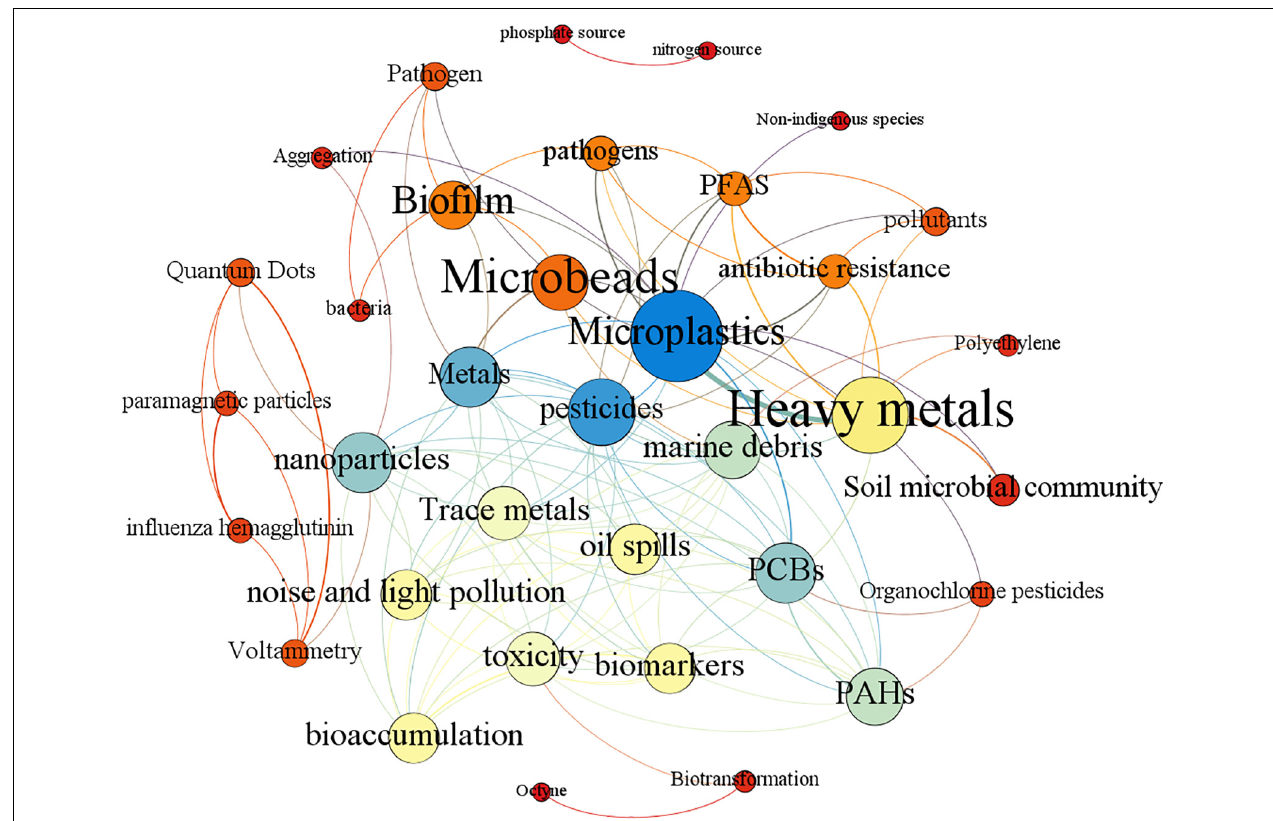
FIGURE 3 | Co-occurrence analysis of keywords with a word frequency of more than five times. The data come from a literature search with MPs, heavy metals, and microbes as the subject terms. Each node is represented as a keyword, edges represent the link between keywords, the color of the node is rendered in degrees, and the color of the edge is rendered in the weight of the